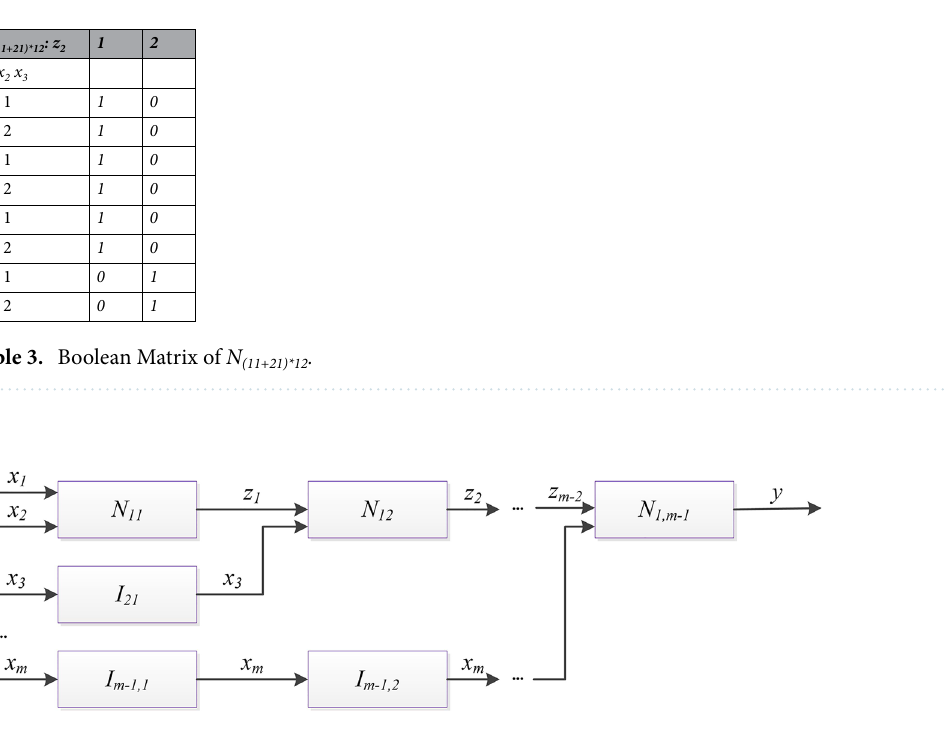
Figure 5. Block-scheme of Fuzzy Networks for theorem